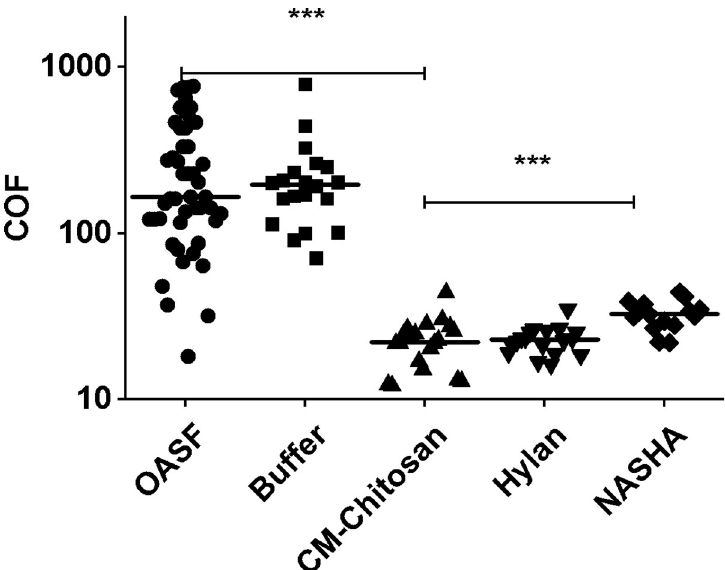
Fig 5. COF measurements of KiOmedine 1 in the p-HEMA tribological model. The lubrication capacity of KiOmedine 1 (N = 4) to reduce COF between the disks in rotating friction was compared to two commercial VSs biomaterial references composed of crosslinked hyaluronic acid, Hylan G-F 20 (N = 4) and NASHA(N = 3), the buffer control (N = 4) and synovial fluids punctured from osteoarthritic patients (N = 10). KiOmedine 1 exhibited similar or higher lubricating capacity compared to Hylan G-F 20 and NASHA (ANOVA, ��� p < 0.0001).